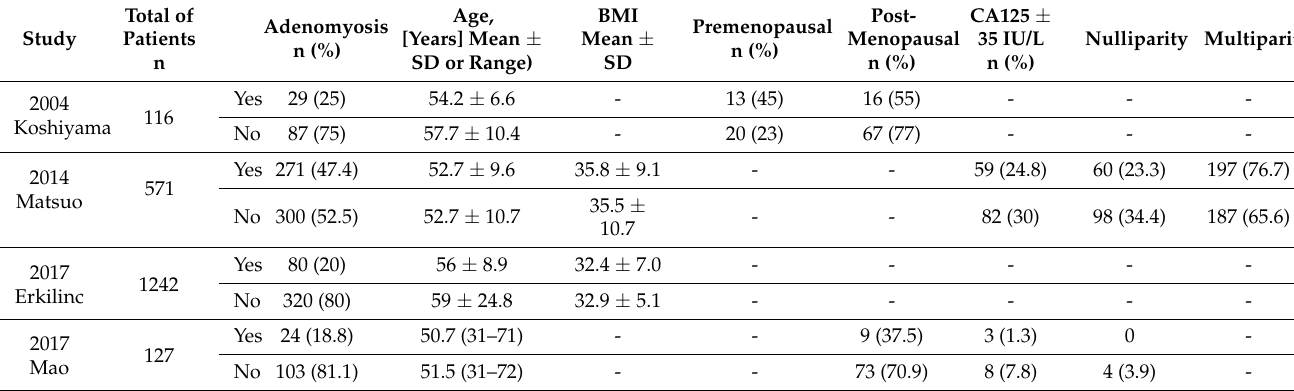
Table 2. Clinical characteristics of endometrial cancer patients with and without